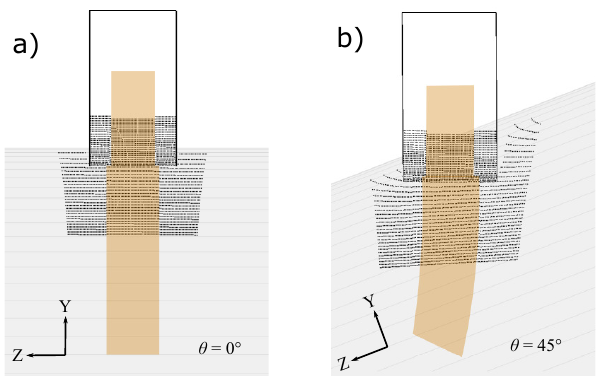
Figure 3. Different placement angles on the reference mandrel. In this picture, the green lines are rays, blue region on mandrel is the substrate, and the blue region attached to the roller is the tape (for interpretation of the references to color in this figure legend, the reader is referred to the web version of this article).